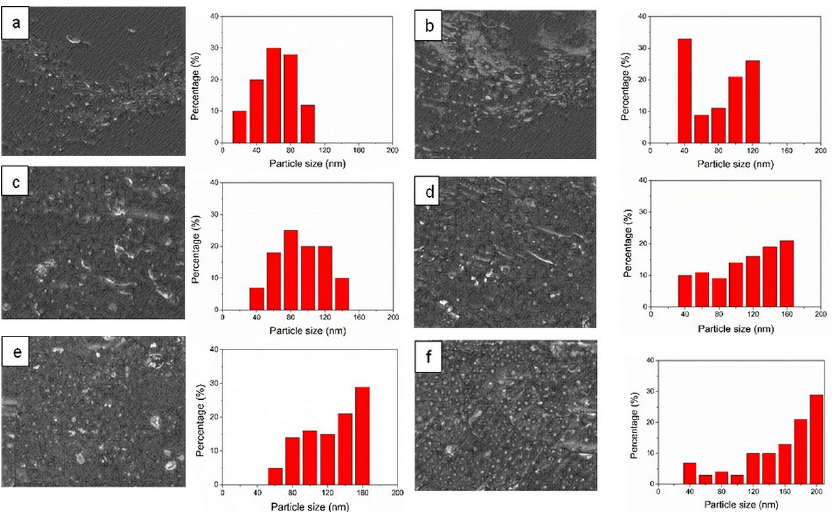
Figure 4. SEM micrographs and average filler particle size of ENR–FeCl 3 filled with CNTs (F7-CNT7) ( a ) and CNT–CCB hybrid filler with various CCB loadings at 2.5 ( b ), 5.0 ( c ), 7.0 ( d ), 10.0 ( e ) and 15.0 phr ( f ).